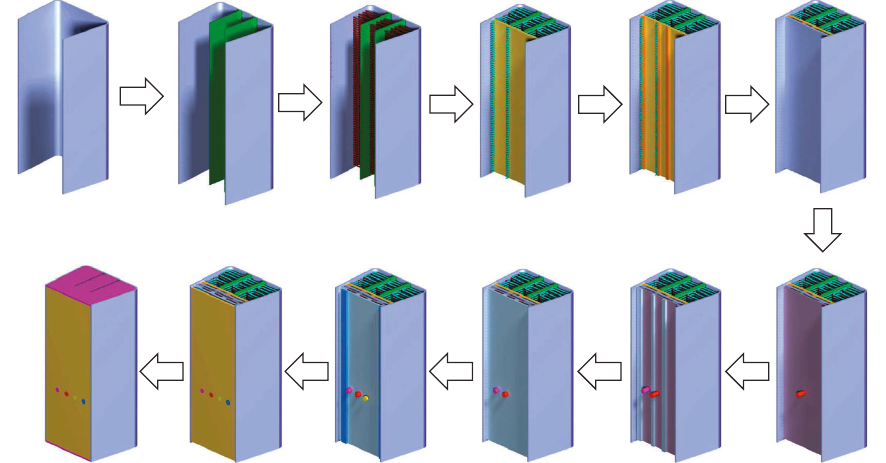
Figure 6: The scheduled assembly sequence of the blanket module. Table 2: Advantages and disadvantages of PPHM and DFA assembly